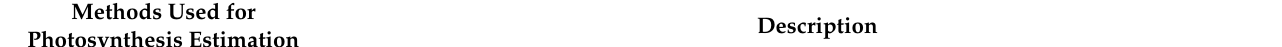
Table 1. Classification of the methods used for photosynthesis estimation and their general description. Methods Used for Photosynthesis